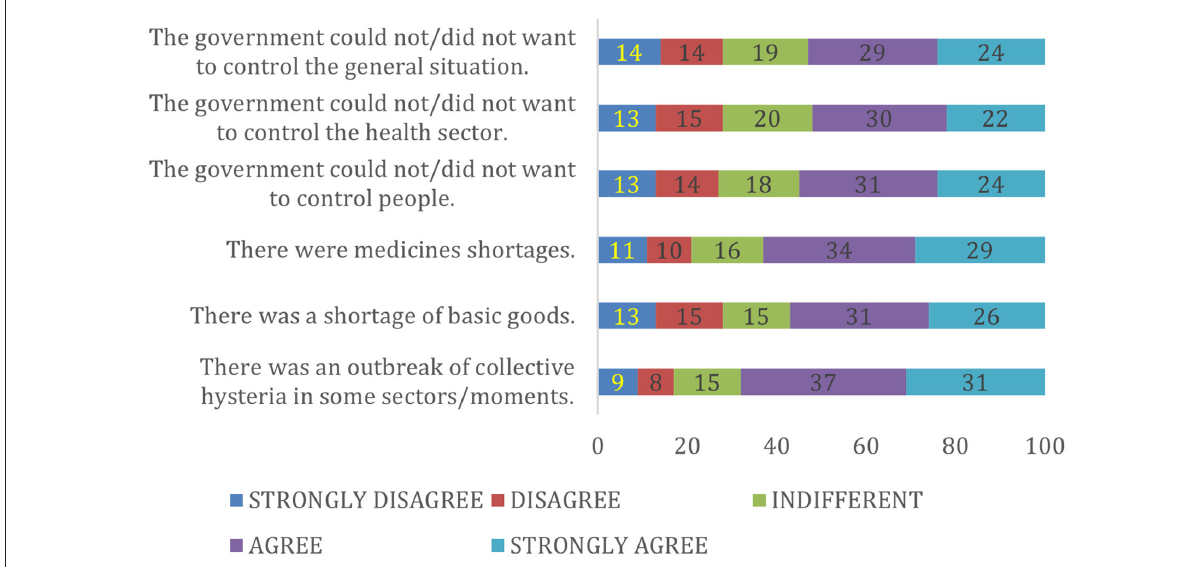
FIGURE1 Perception of the six points of control mechanism in 12 Latin American countries during the first wave of the COVID-19 pandemic.